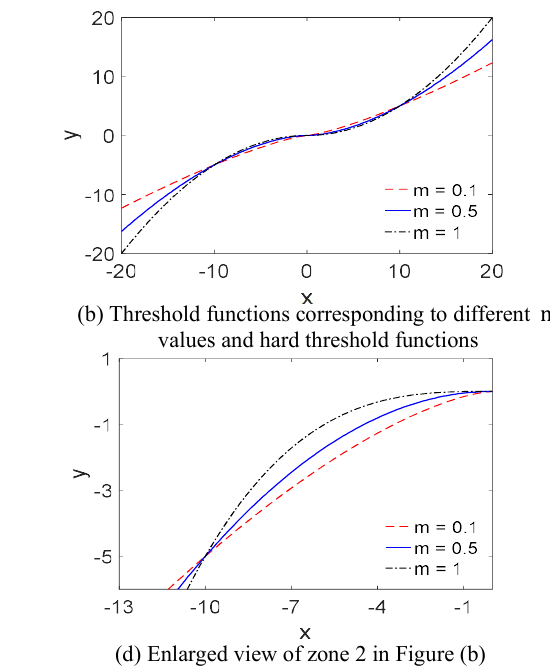
Figure 4. New threshold function